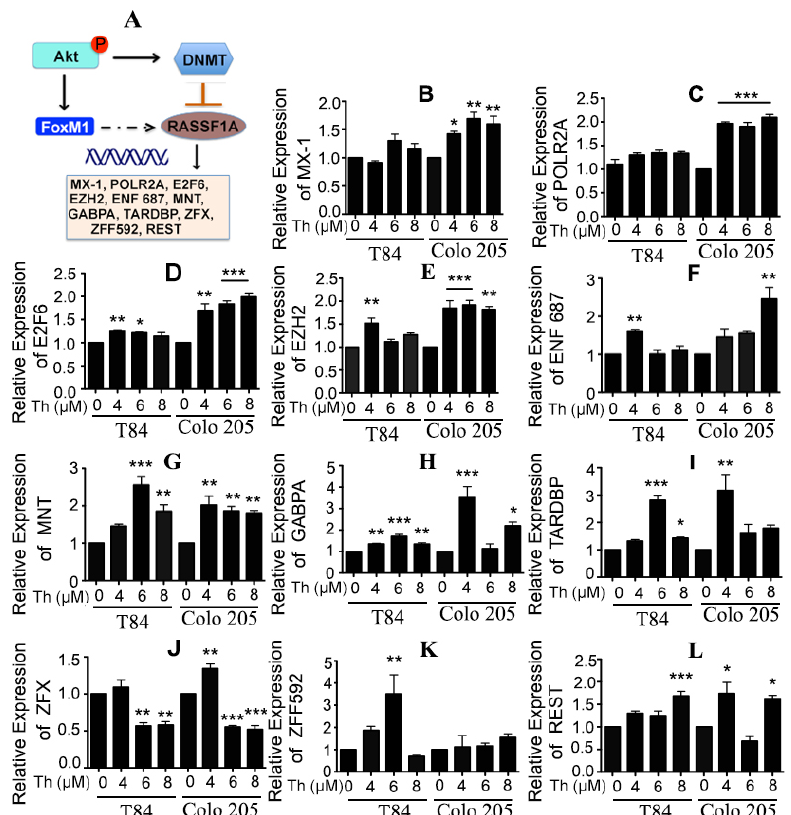
Figure 7. FoxM1 regulates RASSF1A through transcription factor activity. ( A ) Schematic diagram represents a crosstalk between FoxM1 and RASSF1A. ( B ) T84 and Colo 205 cells were treated with thiostrepton as indicated before and the transcriptional level of expression for RASSF1A-promoter-binding transcription factors were determined by qRT-PCR for ( B ) MX-1, ( C ) POLR2A, ( D ) E2F6, ( E ) EZH2, ( F ) ENF 687, ( G ) MNT, ( H ) GABPA, ( I ) TARDBP, ( J ) ZFX, ( K ) ZFF592, ( L ) REST. Bar graphs show quantitative results normalized to GAPDH mRNA levels. Results are from three independent experiments. Statistical significance was determined using one way-ANOVA followed Bonferroni test (* p < 0.05, ** p < 0.01, *** p < 0.001).